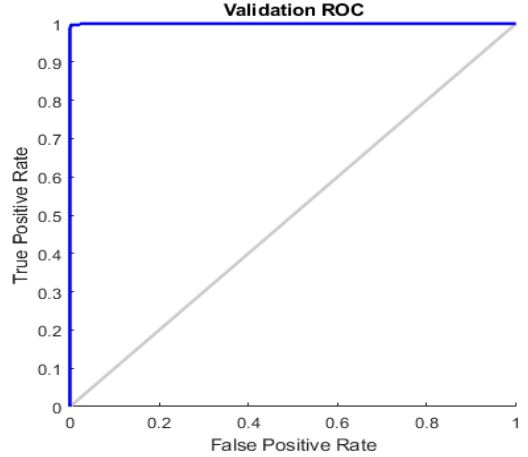
Figure 9. The ROC diagram of the proposed method.